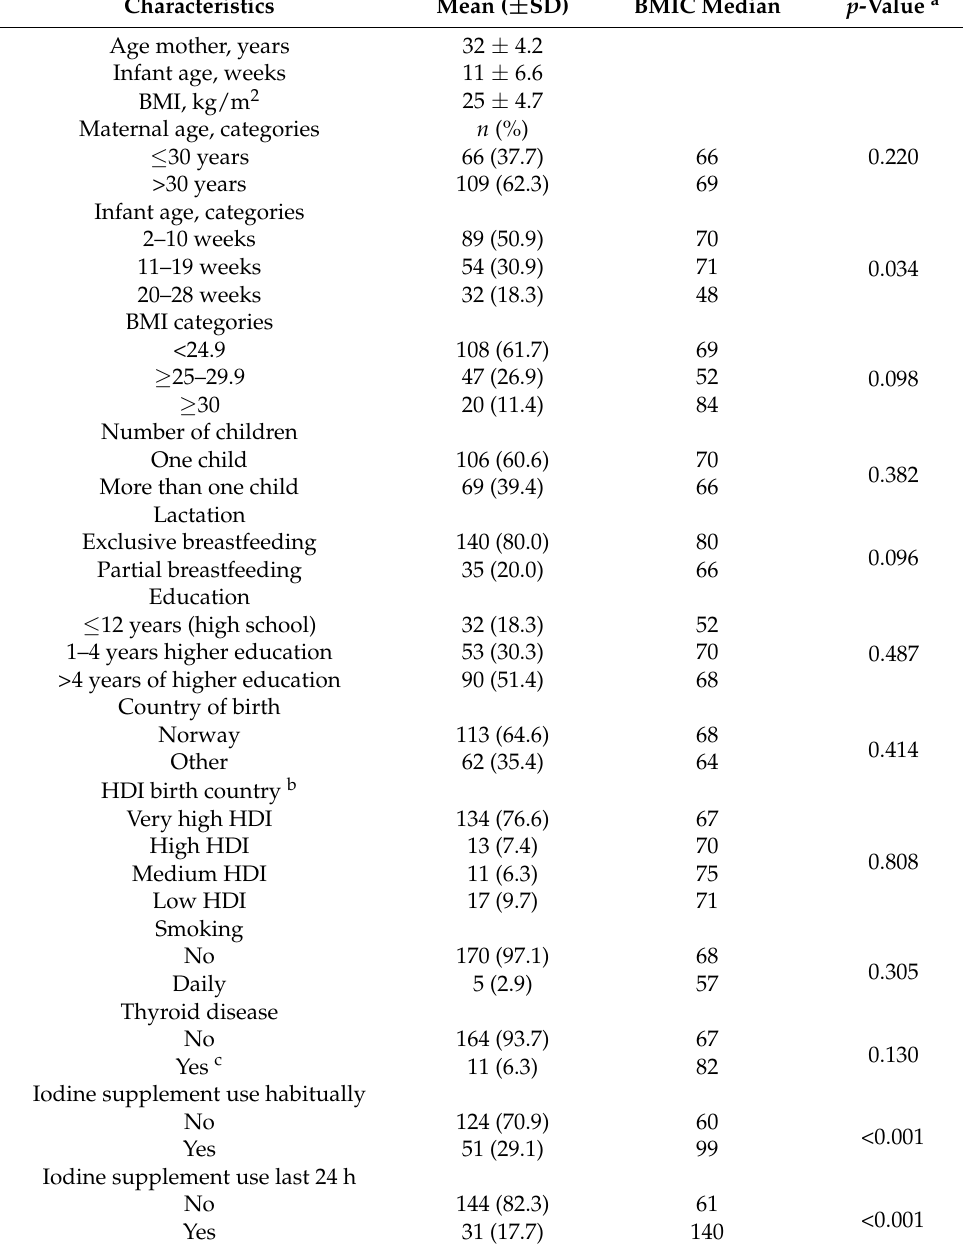
Table 2. Sample characteristics and breast milk iodine concentration by maternal characteristics in lactating women ( n =